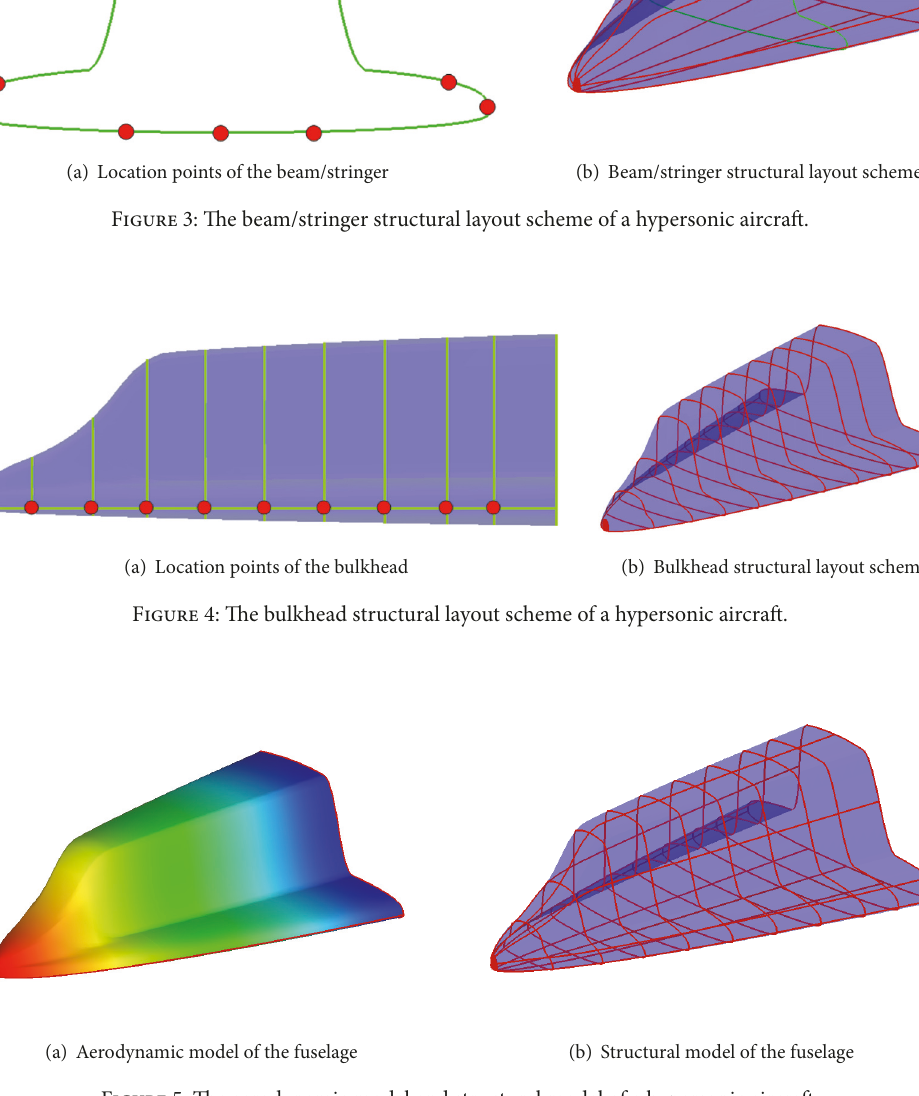
Figure 5: The aerodynamic model and structural model of a hypersonic